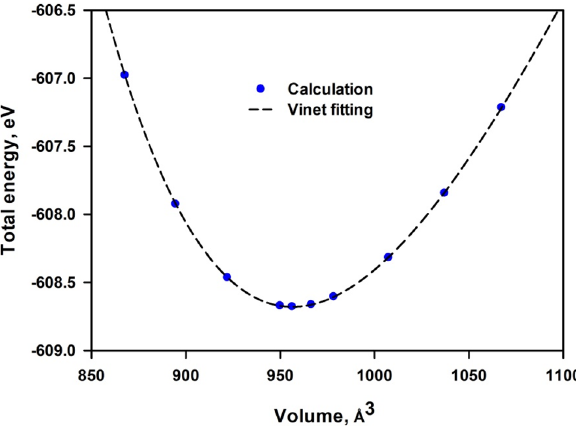
Figure 2. Variation of total energy with volume fitted with the Vinet equation.